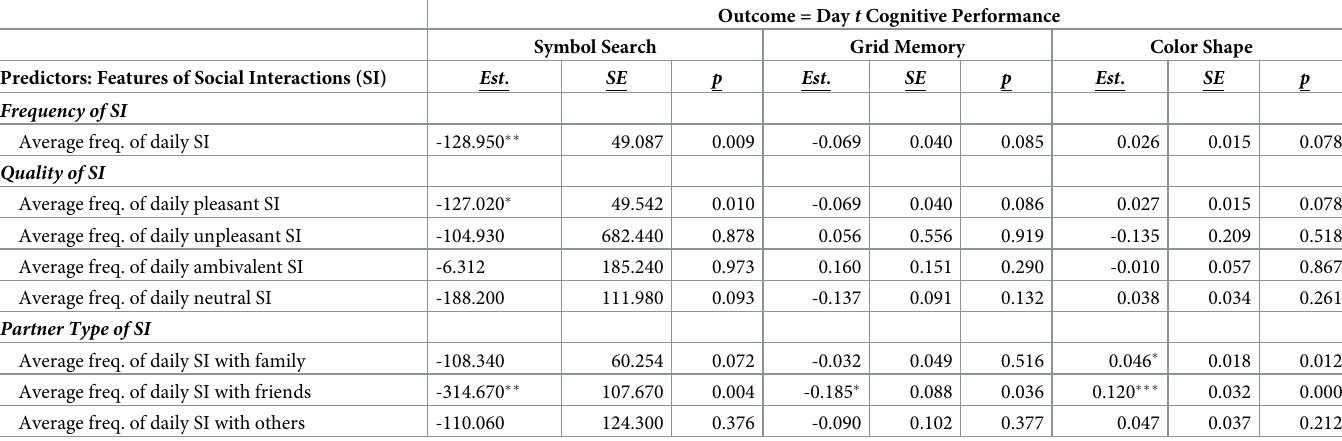
Table 3. Summary of the between-person effects of daily social interactions on daily cognitive